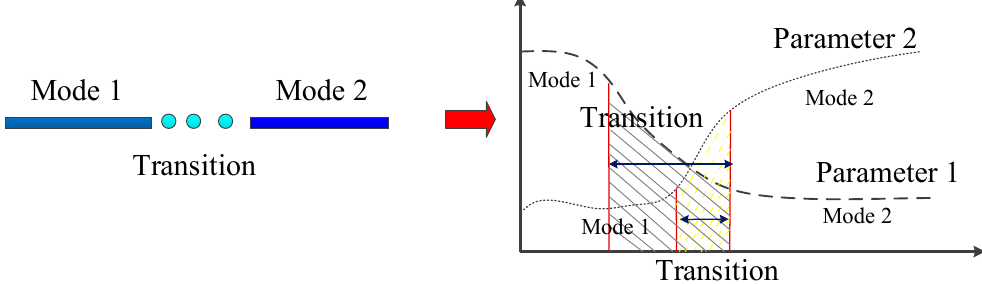
Figure 7. The transition between modes. The left panel shows a simplified graph of the transition from mode 1 to mode 2; the right panel shows the change of the value of corresponding parameters during transportation mode transition.